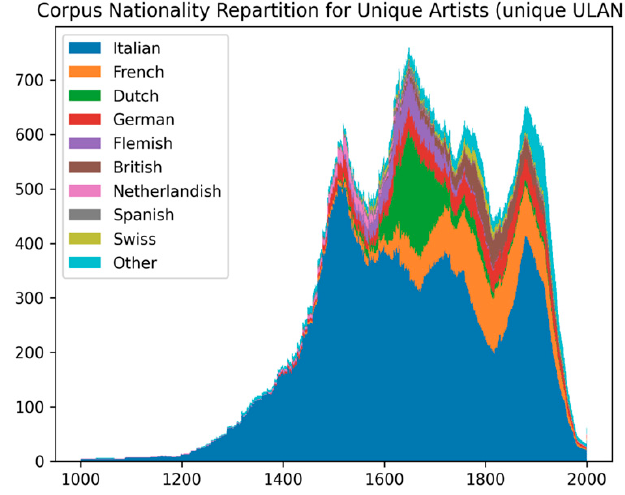
Figure 9. Corpus Nationality Repartition for Unique Artists based on ULAN realignment. (author: Paul Guhennec).